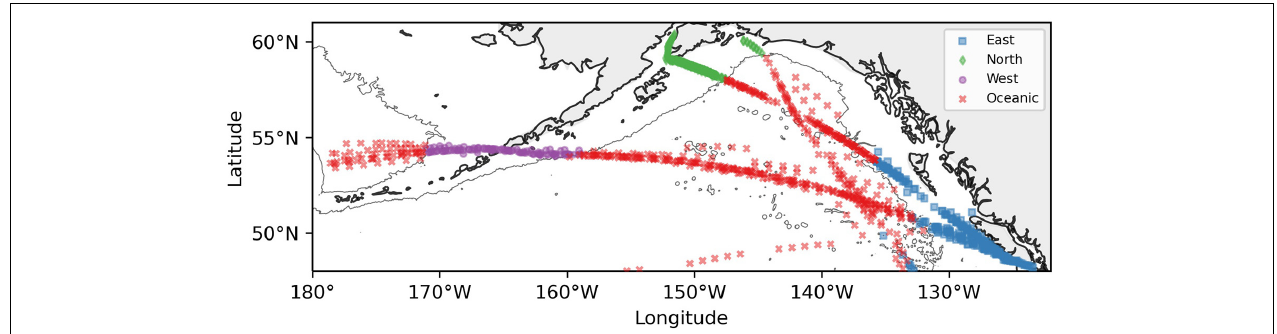
FIGURE 1 | Map of the Gulf of Alaska and eastern Bering Sea with symbols representing locations of Continuous Plankton Recorder samples. Colors and symbols indicate region: eastern shelf/slope, northern shelf/slope, western shelf/slope, and oceanic. Shelf/slope regions include samples < 3,000 m depth and oceanic regions include samples > 3,000 m